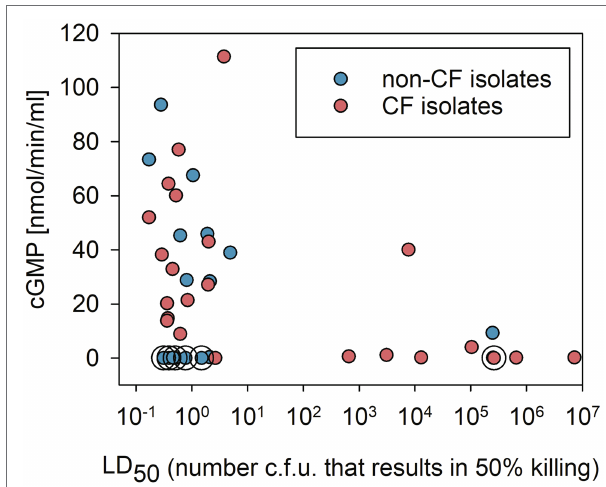
FIGURE 3 | Correlation between virulence in a Galleria mellonella infection model (virulence data from Cullen et al., 2015) and ExoY GC activity in bacterial strains from the international P. aeruginosa reference panel categorized into CF or non- CF isolates. GC activities plotted correspond to the averages of peak values shown in Figure 2 . Circles around data points indicate that these samples correspond to strains that were predicted to lack ExoY activity due to the presence of frameshift P242 in exoY as described in Supplementary Figure 1A